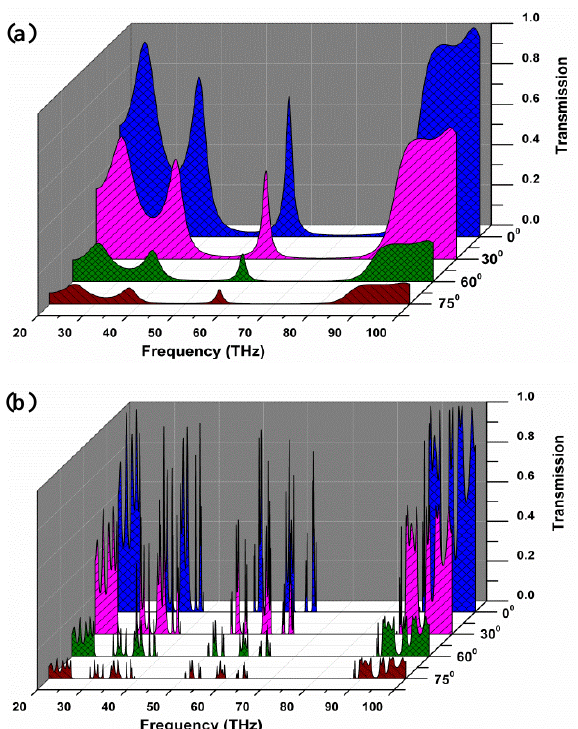
Figure 3: TE Transmittance spectrum of BiTeCl based Conventional and Fibonacci Photonic crystal structures of (a) 5th and (b) 10th generations.